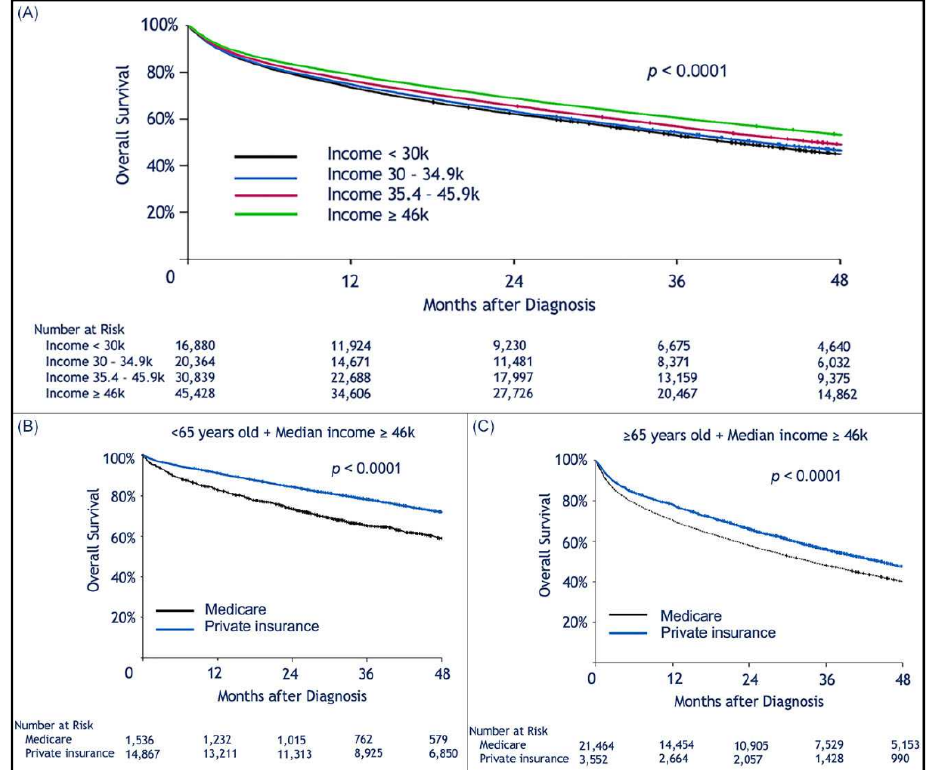
by 59% for patients with Medicaid ( p < 0.0001) and by 62% for those without insurance at